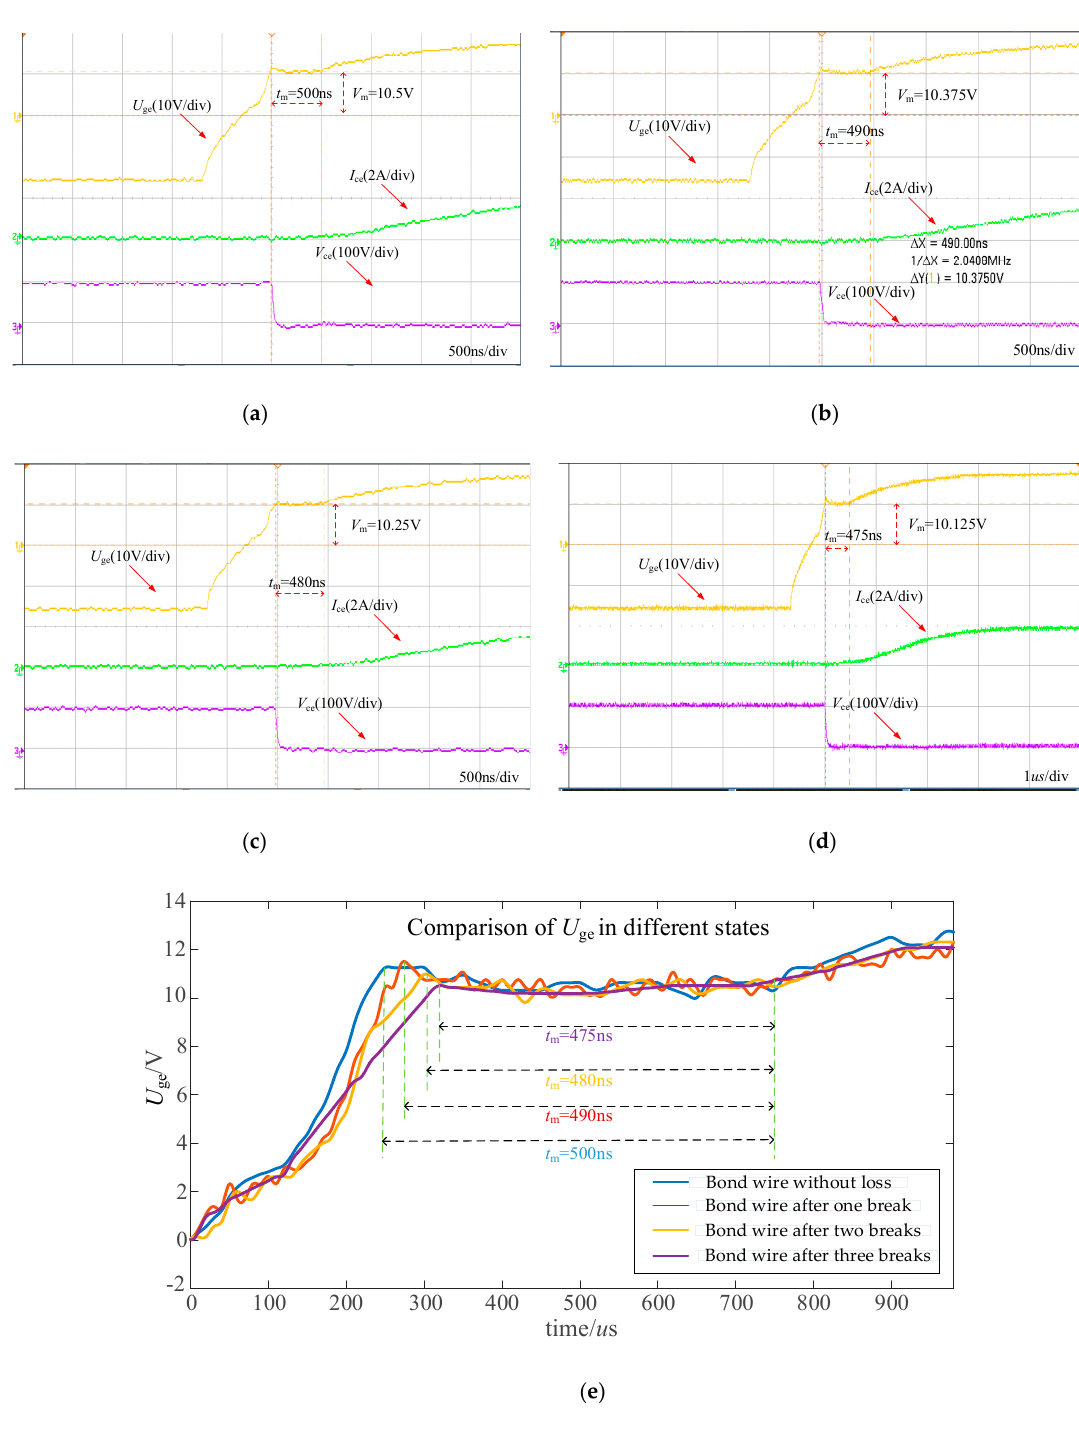
Figure 9. U ge , I ce , and V ce waveforms with different IGBT bond line losses: ( a ) bond wire without loss; ( b ) bond wire after one break; ( c ) bond wire after two breaks; ( d ) bond wire after three breaks; ( e ) comparison of U ge with different IGBT bond line losses.